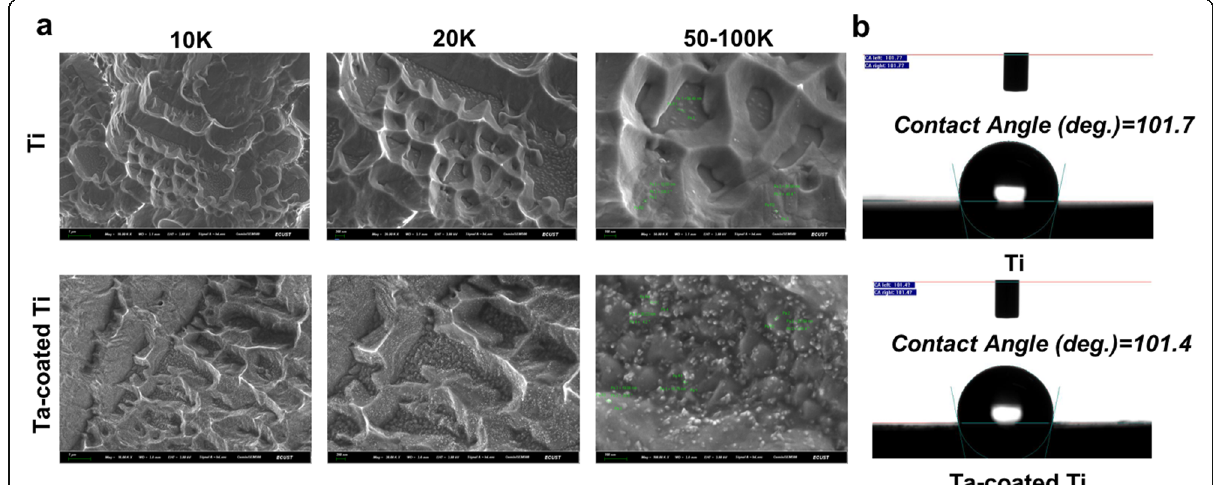
Fig. 2 a SEM morphologies of Ti an Ta-coated Ti plates under different magnifications. b Surface wettability. No obvious difference for contact angles ( p >